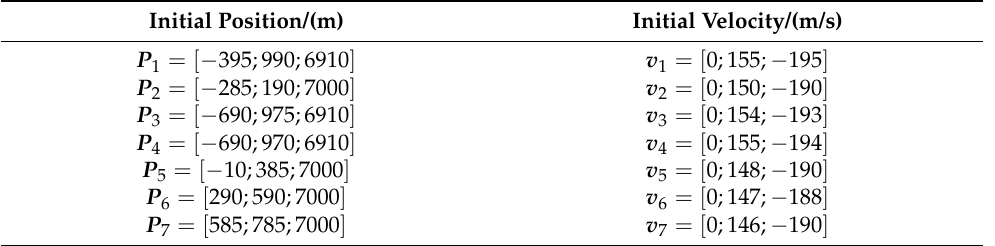
Figure 6. Top view of MAV/UAVs group formation. In order to verify the effectiveness of the trajectory tracking for MAV, two simula- tions are carried out in the presence of external disturbances. The first simulation is con- ducted under the DSC and nonlinear disturbance observer based (DSC + NDO) composite